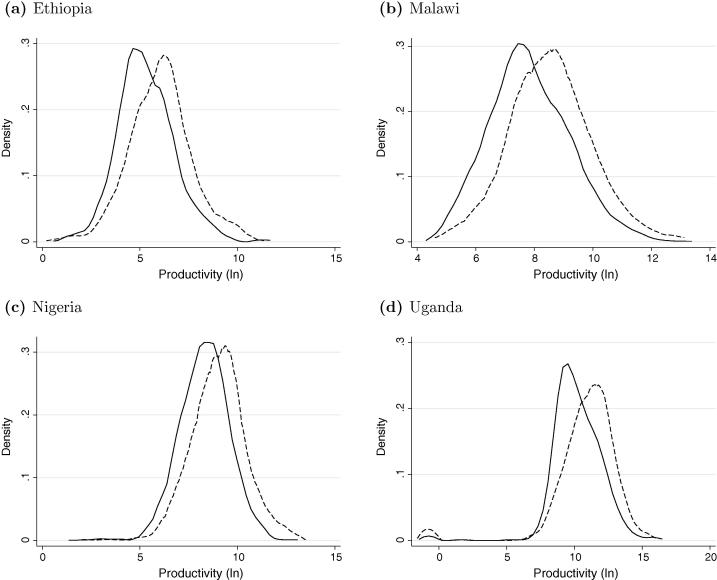
Productivity dispersal – by gender. Note(s): In (a)–(d) the continuous lines represent the productivity of enterprises with a female enterprise owner and the dotted lines the productivity of enterprises with a male enterprise owner. Authors’ own calculations based on LSMS-ISA data.